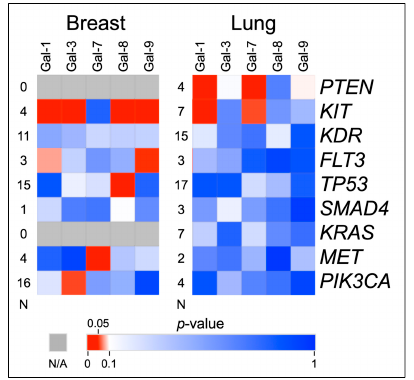
Figure 2. Heat Map of Mutated versus Wild-Type Galectin Levels T-Tests. This figure shows the p - values of t-test comparisons of the serum galectin levels in mutated vs. non-mutated genes in breast and lung cancer patients. Levels of galectin-1, -3, -8, and -9 are significantly elevated when KIT is mutated in breast cancer samples. Levels of galectin-1 and -7 are significantly elevated when PTEN and KIT are mutated in lung cancer samples. “N” indicates the number of mutated samples in the comparison. Figure 2 shows that despite the small number of mutations in the KIT gene, they cor- related with increases in several galectins in both cancers. These comparisons are charted in Figures 3 and 4. Additionally, PTEN was found to have some correlations with galectin levels in NSCLC patients, as seen in Figure 4.